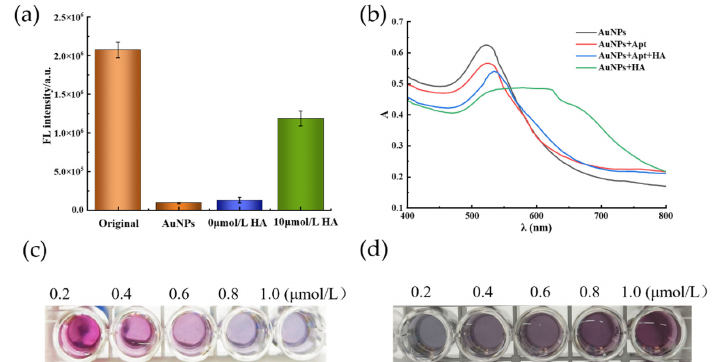
Figure 1. ( a ) Fluorescence signal of the histamine aptamer in different systems. ( b ) The UV–Visible absorption spectrogram of detection principle feasibility (histamine concentration of 10 μ mol/L). ( c ) Colorimetric results of different histamine concentrations in the same volume of AuNP solution at the same aptamer concentration (from left to right histamine concentrations in the order of 0.2–1.0 μ mol/L). ( d ) Colorimetric results of histamine at 2.0 μ mol/L concentration in solutions with different aptamer concentrations and AuNPs (from left to right aptamer concentration of 20–100 nmol/L).